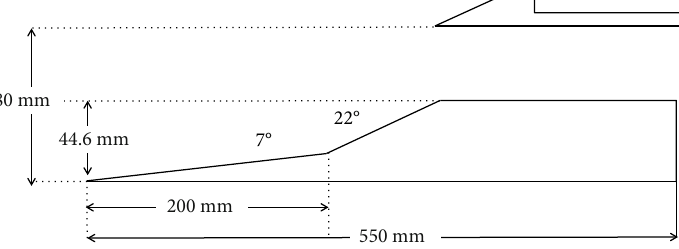
Figure 16: Geometry for the 2D double wedge ramp scramjet inlet (mm).